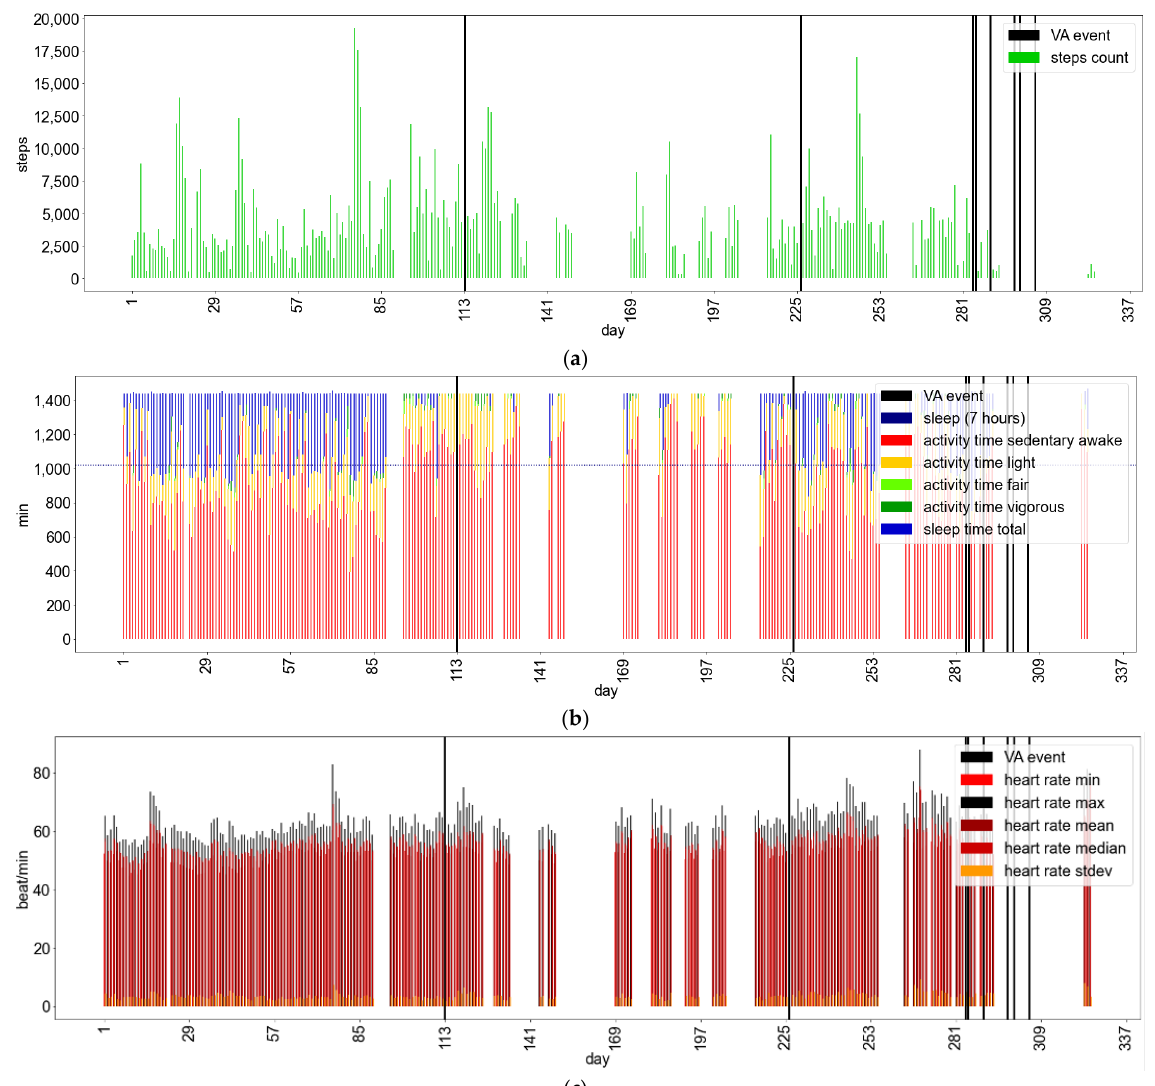
Figure A4. Daily life behaviors (bars) and VA events (strokes) observed in the Fitbit monitoring time interval for Patient 18; ( a ) steps; ( b ) physical activity — sedentary awake includes non-measured and measured-as-sedentary durations excluding measured sleep — and sleep duration; ( c ) heart rate.